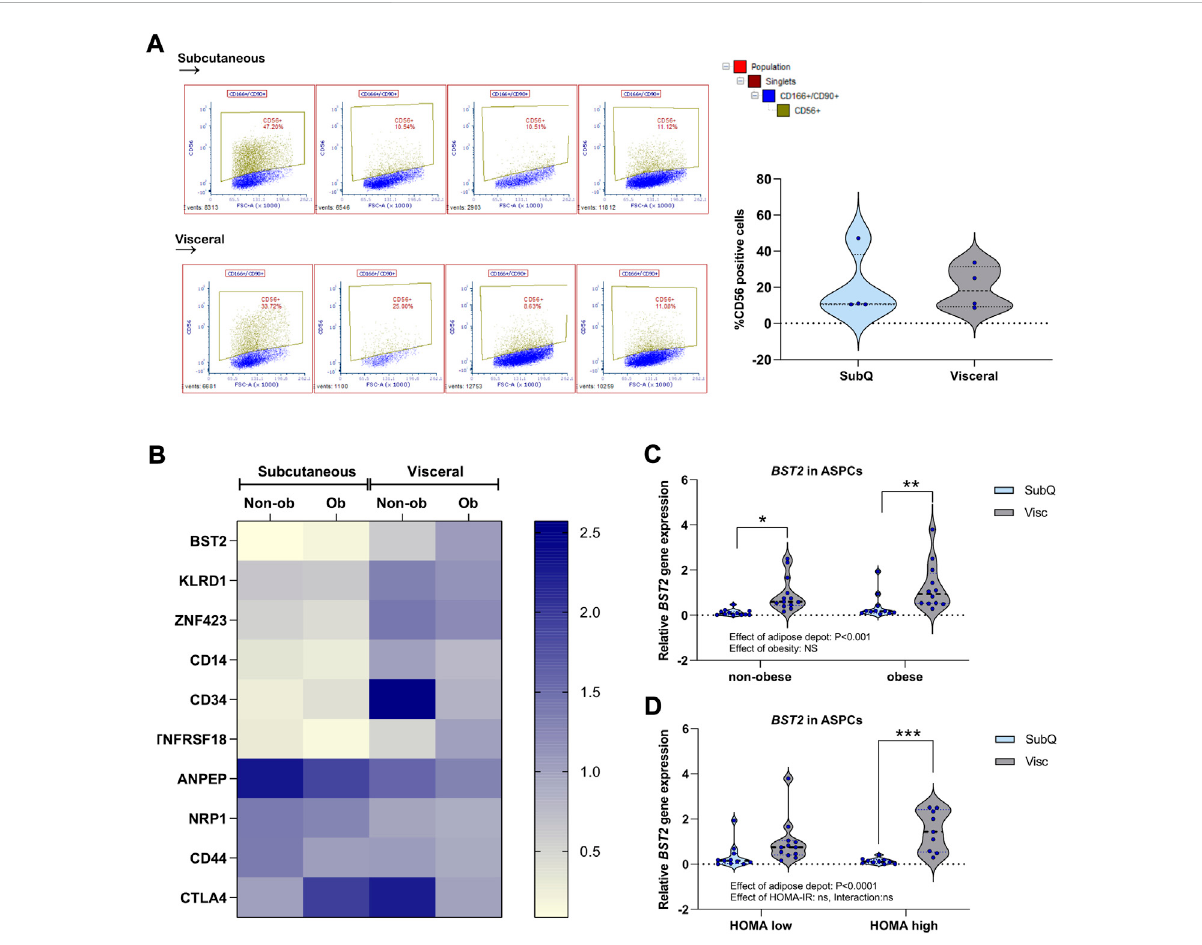
FIGURE 3 Characterization of APSCs derived from human SAT and VAT. (A) APSCs derived from SAT and VAT were cultured and characterized for surface expression of CD90, CD166 and CD56 using fl ow cytometry. Granularity and relative size were evaluated by side- and forward scatter area (SSC-A andFSC-A)toselectthepreadipocytepopulationforanalysis.Fromthesecells,singlecellswereselectedbyevaluationofforwardscatterheightand width (FSC-h and FSC-W). Within this population, cells positive for CD166, CD90 and CD55 were selected. Gating strategy: preadipocytes/ singlets/CD166+CD90+/CD56+. Flow cytometry illustrated a smeared DIM CD56 + population within the preadipocyte population in both visceral and subcutaneous adipocytes. Right: summary graph of CD56 + APSCs ( n = 3) (B) Sub-cultured APSCs harvested at 80% con fl uency was analyzed using GenEx qPCR array. Heatmap shows top 10 genes with lowest p -values from pairwise comparisons among the four groups. All data is shown in (Supplementary Material S1) (C) Data derived from the qPCR array on APSCs showing BST2 mRNA levels. (D) Data derived from the qPCR array on APSCsshowing BST2 mRNAlevelswhensampleswerereorganizedbasedonHOMA-IR.Asclinicaldatawerenotavailableforallsubjects,thesample groups were slightly reduced compared to the non-obese vs obese groups. HOMA high represents HOMA-IR values over 2 and HOMA low representsHOMA-IRvaluesunderorequalto2.SATHOMAlow: n =11(7non-obese,4obese);SATHOMAhigh: n =10(4non-obese,6obese);VAT HOMA low: n = 12 (8 non-obese, 4 obese); VAT HOMA high: n = 9 (4 non-obese, 6 obese). Data are presented as violin plots with thick dotted line showing median and thin dotted lines showing quartiles. Two-way anova assessed difference between groups and depots. Signi fi cant post-test